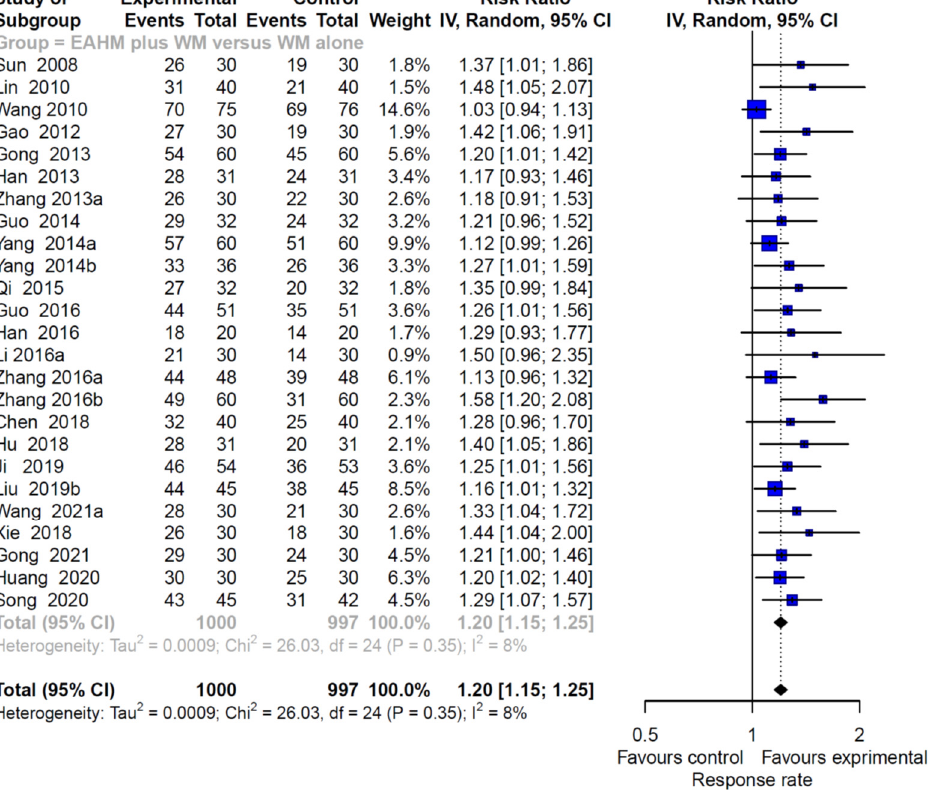
Figure 8. Forest plot of the trials reporting the effect of combined East Asian herbal medicine and western medicine therapy on the response rate for peripheral neuropathy.